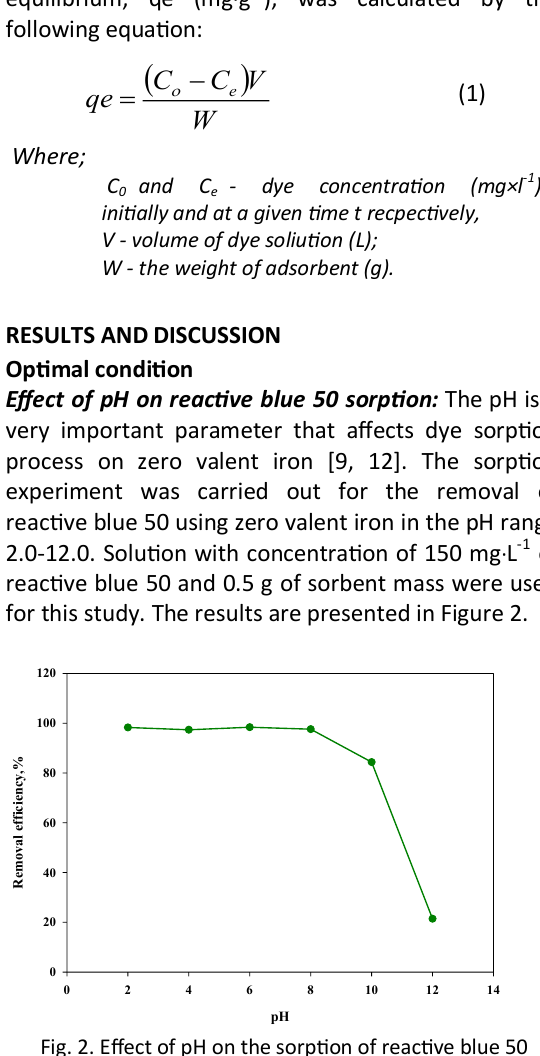
Fig. 2. Effect of pH on the sorption of reactive blue 50 (C 0 = 150 mg·L -1 , sorbent mass: 0.5